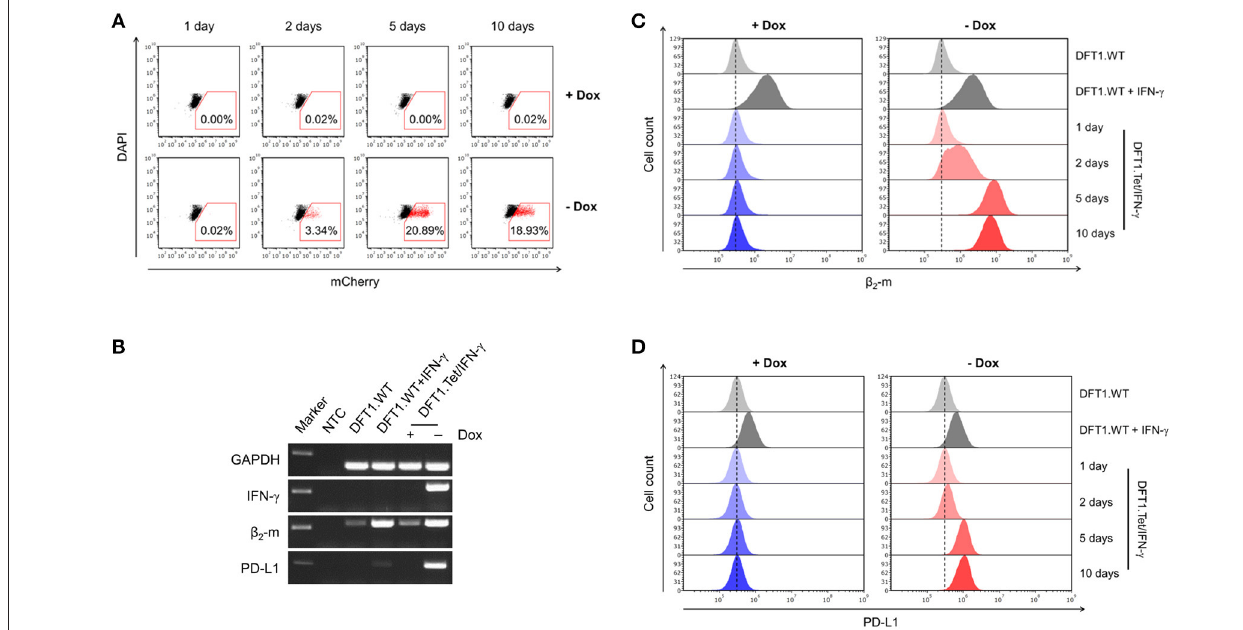
FIGURE 2 | Gene expression following doxycycline removal and the downstream effects of IFN- γ . (A) Flow cytometric analysis of mCherry expression in DFT1.Tet/IFN- γ with and without doxycycline. DFT1.WT cells treated with and without 5ng/ml IFN- γ for 24h (B,C) or 72h (D) were used as positive and negative controls for β 2 -m and PD-L1 upregulation, respectively. (B) mRNA expression of IFN- γ , β 2 -m and PD-L1 analyzed by RT-PCR. Results are shown for DFT1.Tet/IFN- γ cells cultured with and without doxycycline for 5 days, and GAPDH was used as a reference gene. NTC , no template control. Marker shows 250 bp-size band. (C) β 2 -m upregulation on DFT1.Tet/IFN- γ following doxycycline removal. Cells were stained with mouse anti-devil β 2 -m antibody followed by goat anti-mouse IgG conjugated to AlexaFluor 488 and were analyzed by flow cytometry. (D) PD-L1 upregulation on DFT1.Tet/IFN- γ following doxycycline removal. Cells were stained